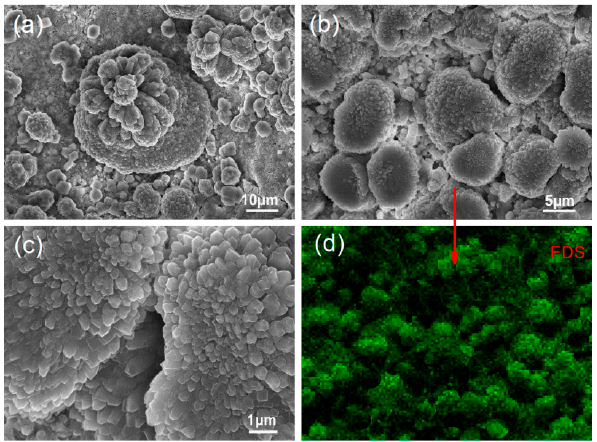
Figure 8. ( a – c ) SEM images of GO/PAM/cement composites with unmodified GO nanosheets. ( d ) Carbon map of the area presented in ( b